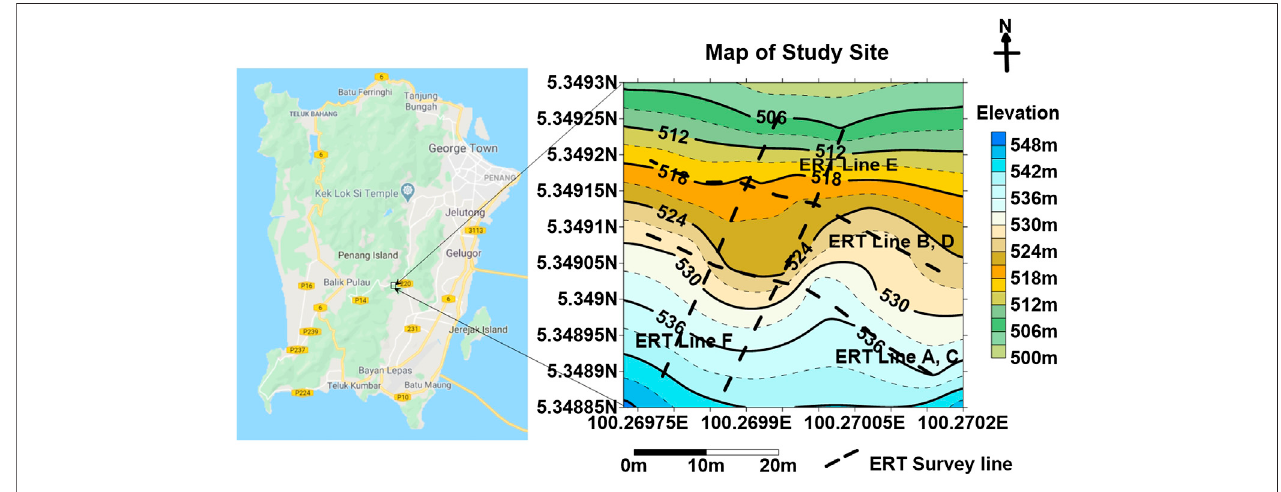
FIGURE 1 | Location map of the study